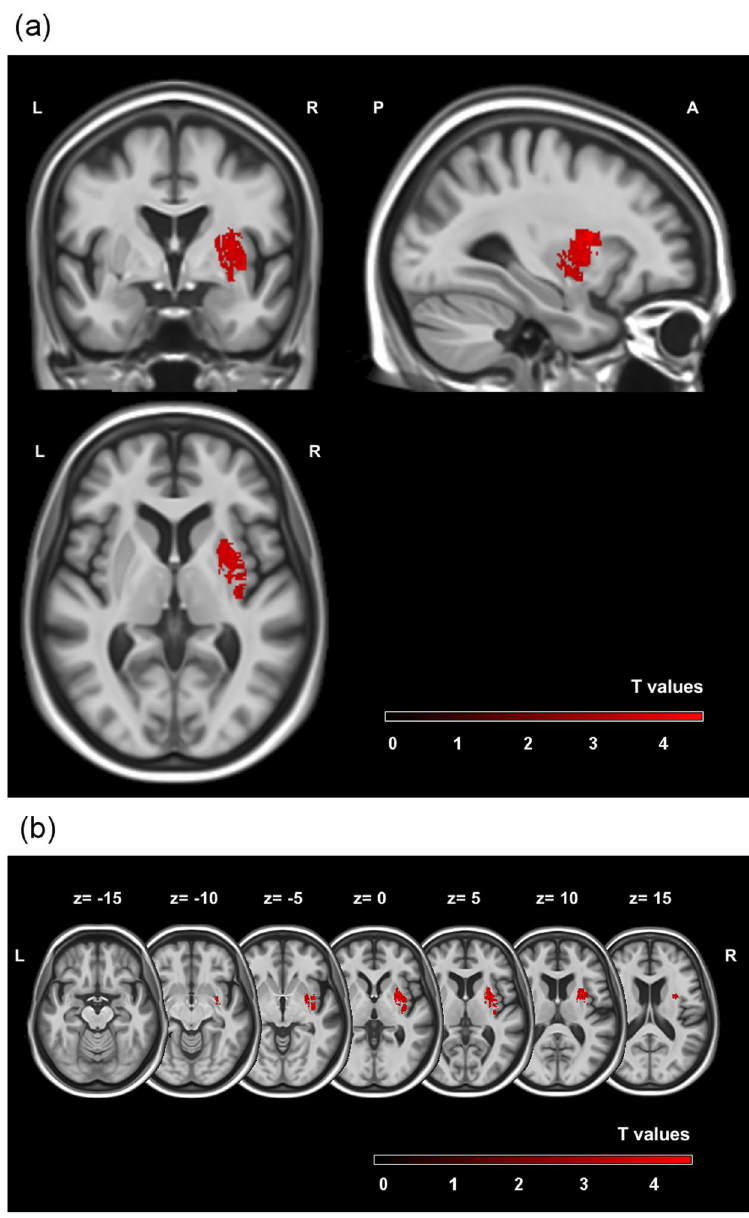
Figure 2. Significant cluster ( 1 ) of the voxel-based lesion symptom mapping analysis presented in an overview map ( a ) and on axial slices from caudal (z = − 15) to cranial (z = 15) from a standard MRI template ( b ). The maps show permutation-corrected results ( p < 0.05) at cluster level and with a threshold of p < 0.001, overlaid on a standard MRI template. Scale bars represent t-scores. L: left hemisphere, R: right hemisphere, A: anterior, P: posterior. Note that z-coordinates relate to MNI